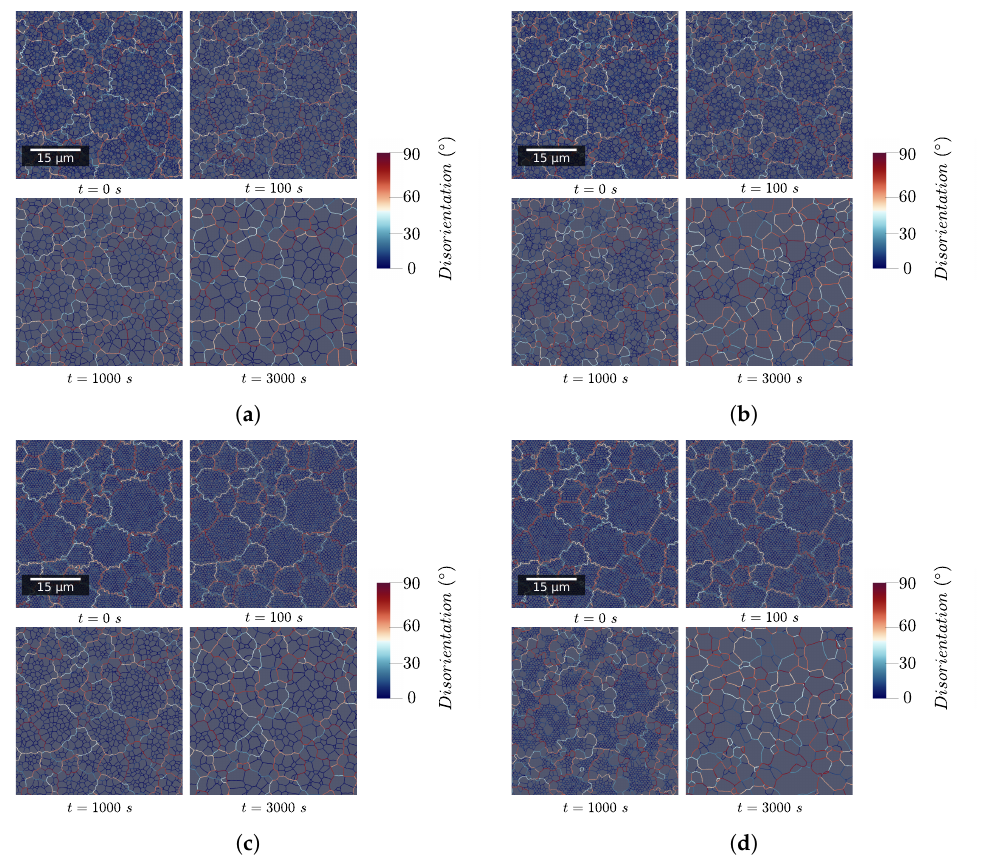
Figure 5. Evolution of the GB network with time for the four test cases in a zone at the cen- ter of the RVE. ( a ) Experimental subgrain size distribution— γ h . ( b ) Experimental subgrain size distribution— γ h , M h . ( c ) Uniform subgrain size distribution— γ h . ( d ) Uniform subgrain size distribution— γ h , M h